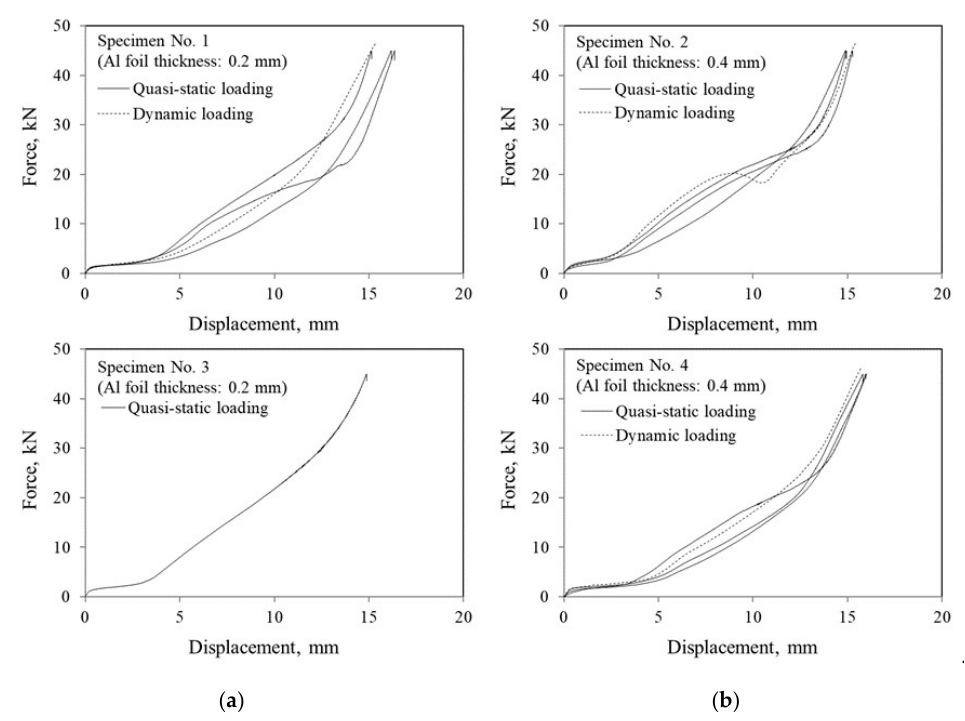
Figure 11. Compressive force-displacement curves in the transversal direction: ( a ) foil thickness 0.2 mm and ( b ) foil thickness 0.4 mm.